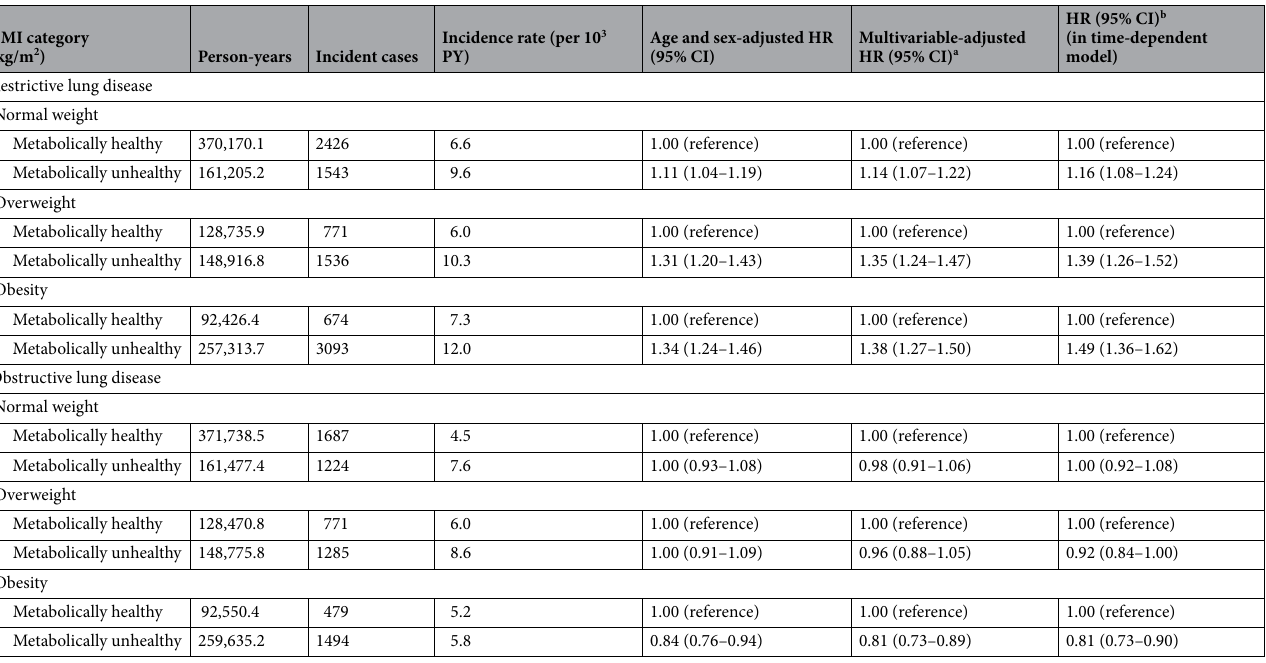
Table 4. Development of restrictive lung diseases by metabolically healthy status stratified by body mass index category. a Estimated from parametric proportional hazard models. The multivariable model was adjusted for age, sex, centre, year of screening examination, education level, smoking status, alcohol intake, physical activity level, and total energy intake. b Estimated from parametric proportional hazard models with BMI category, smoking status, alcohol intake, physical activity level, and total energy intake as time-dependent categorical variables and baseline age, sex, centre, year of screening examination, and education level as time-fixed variables. BMI body mass index, CI confidence interval, HR hazard ratio, PY person